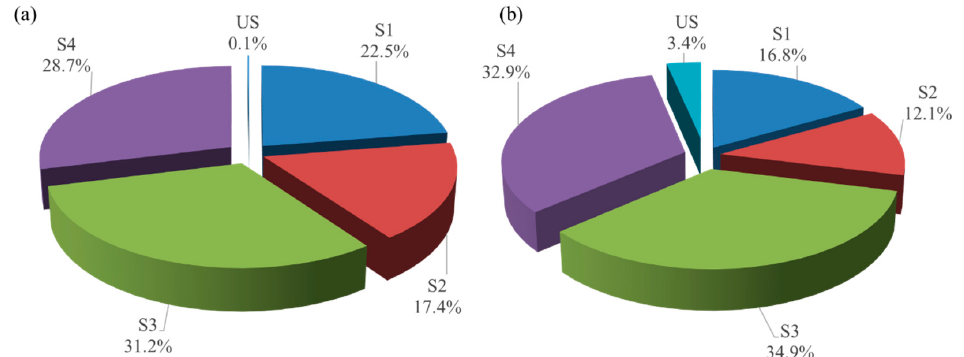
Figure 7. Average contributions of pollution sources to the water quality based on the PMF model in the LP ( a ) and HP ( b ) zones. The S1, S2, S3, S4, and US in ( a ) were identified as point source pollution of industrial sewage, point source of petrochemical enterprises wastewater, non-point source pollution of overland runoff, point source pollution of domestic sewage, and one undefined source, respectively. The S1, S2, S3, S4, and US in ( b ) were identified as non-point source pollution of overland runoff, point source of petrochemical enterprises wastewater, point source pollution of domestic sewage, point source pollution of industrial sewage, and one undefined source,